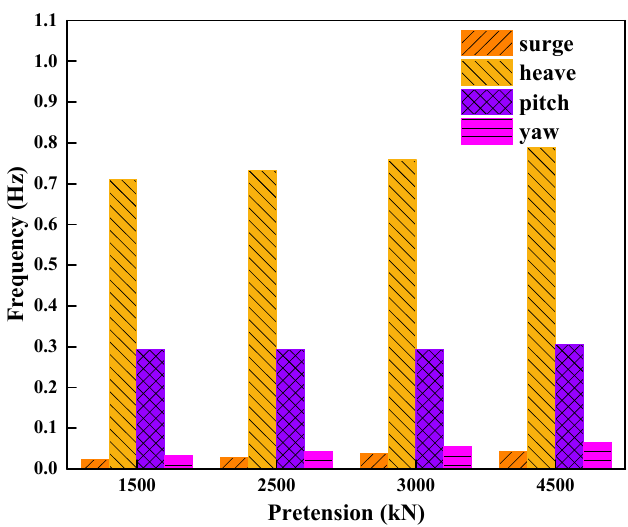
Figure 10. Natural frequencies of surge, heave, pitch and yaw in different pretension conditions.